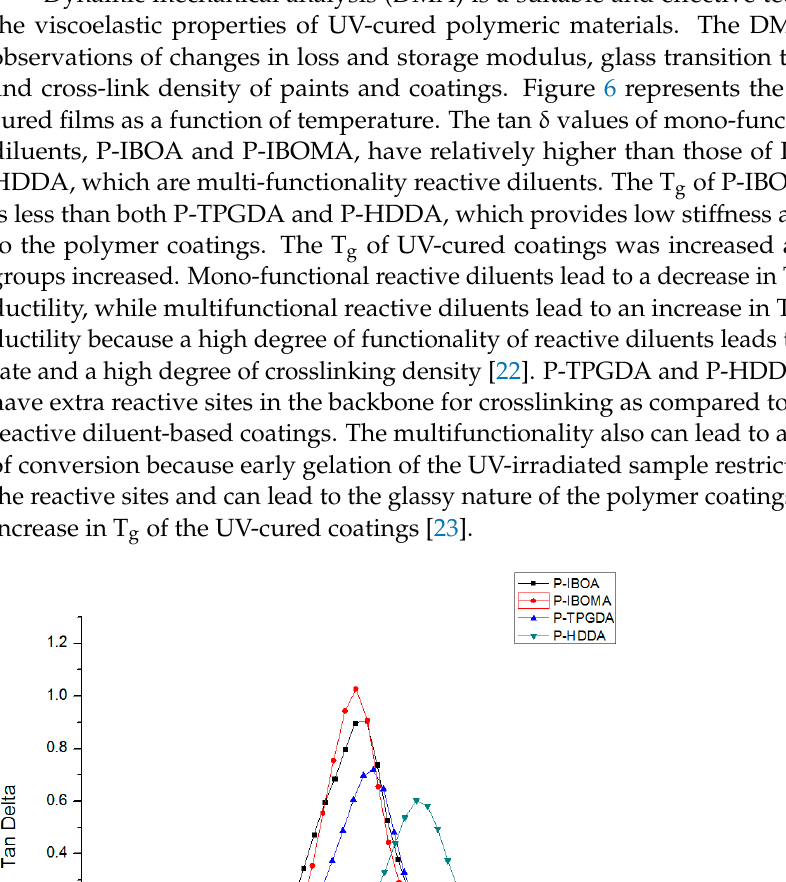
Figure 5. ( A ) Rigid body type pendulum in RPT instrument: Knife edge-type for the curing process. ( B ) Curing behavior of UV-curable coatings. ( B ) Curing behavior of UV-curable coatings.